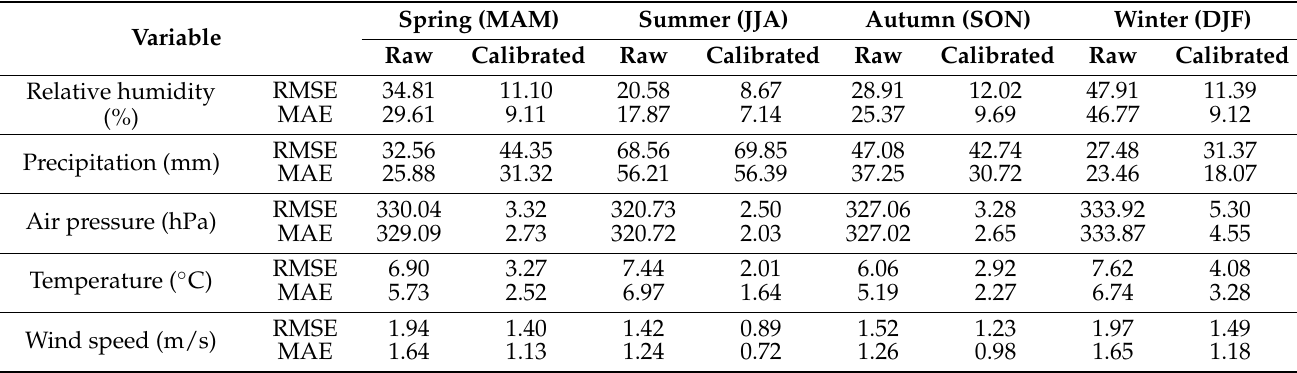
Table A1. Performance of this adjustment approach averaged over the 36 QTP sites stratified by seasons in terms of RMSE and MAE values before (raw) and after (calibrated) the first adjustment based on the GCM MPI data. The metrics are measured against the site observations. Same as Table 3 but using GCM MPI data.